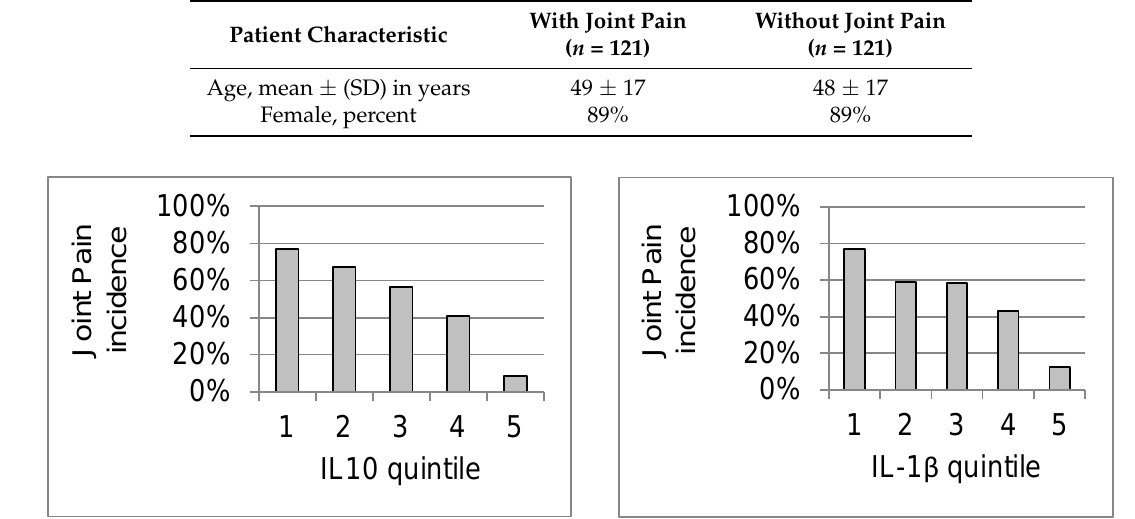
Table 1. Patient characteristics 20 months post chikungunya infection.